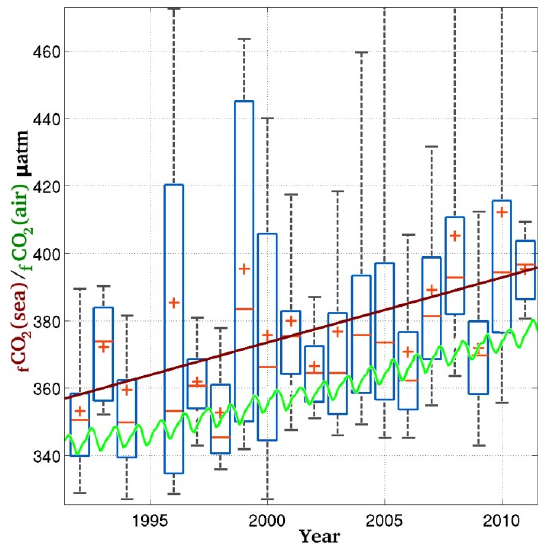
Figure 3. Yearly binned f CO 2 measurements from the SOCAT database. The interpolated average rate of ETPO f CO 2 increase is shown as a red line, with the atmospheric f CO 2 data shown as a green line. The blue boxes represent the 5th and 95th percentile f CO 2 , with the small red lines indicating yearly averages, and the red crosses indicating the yearly